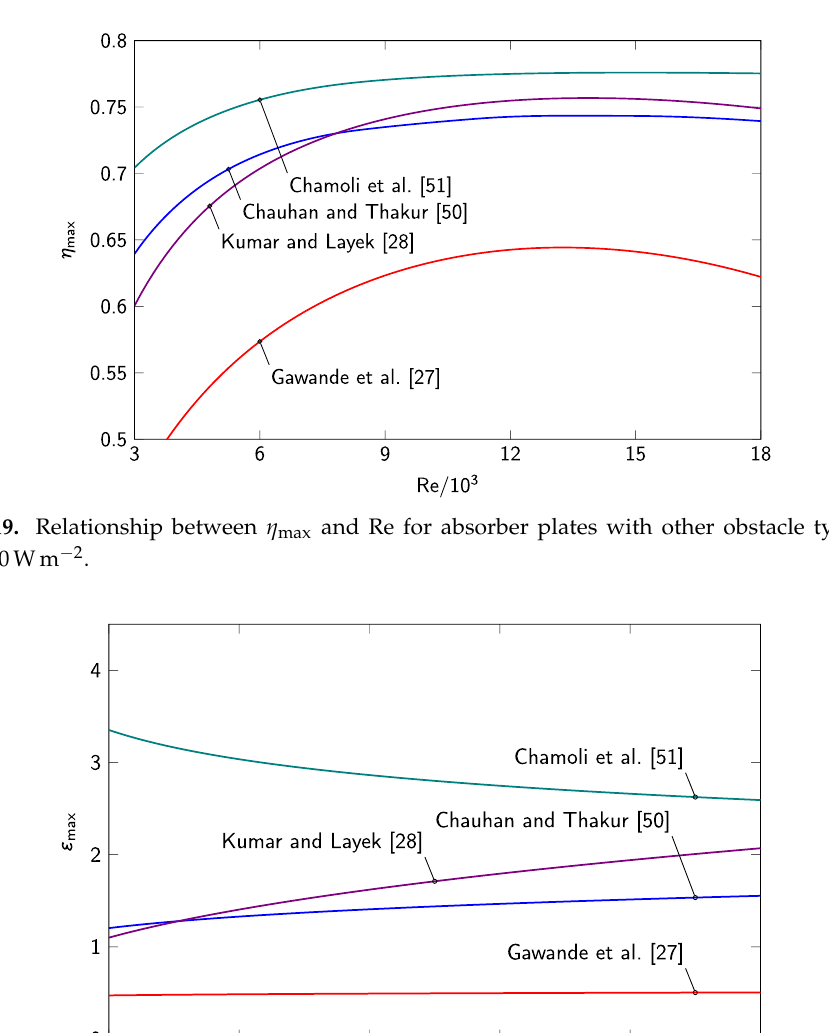
Figure 18. Relationship between η max and Re for absorber plates with other obstacle types and ˙ G = 500Wm − 2 .